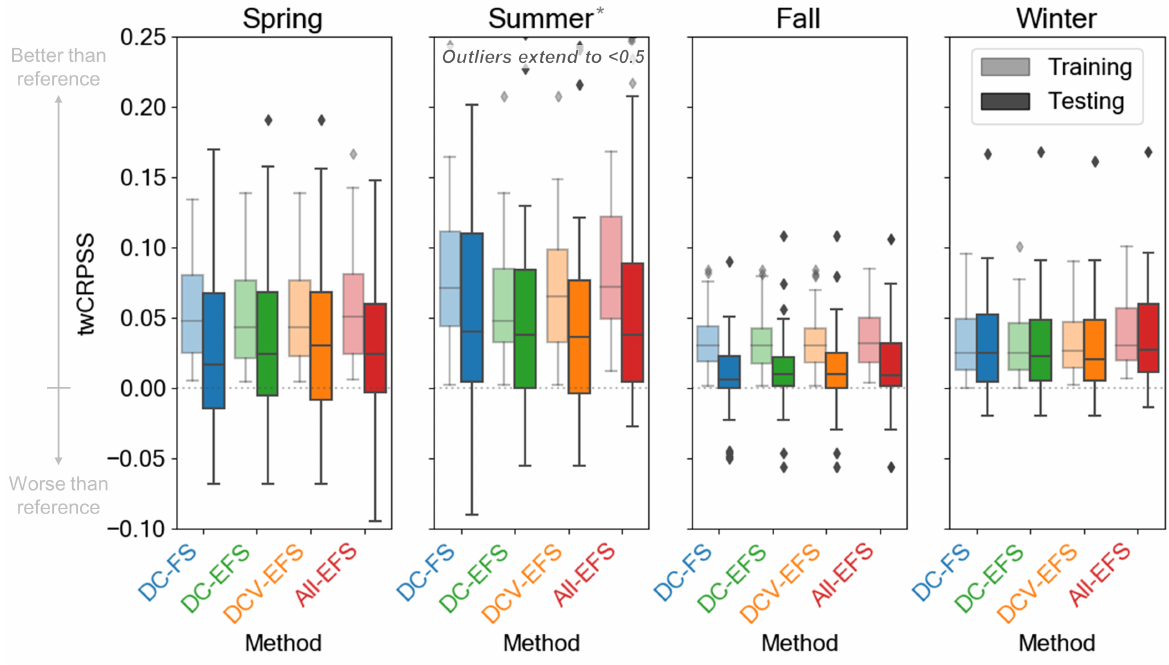
Figure 4. Box-and-whisker plots of 75p twCRPSS distributions across stations (46 stations in each boxplot, except in summer) after predictor optimization with four methods. The dotted zero line separates values that indicate improvement (positive values) vs. deterioration (negative values) compared to the reference twCRPS using control predictors. Performance differences between training (lighter colors) and testing (darker colors) informs about the degree of